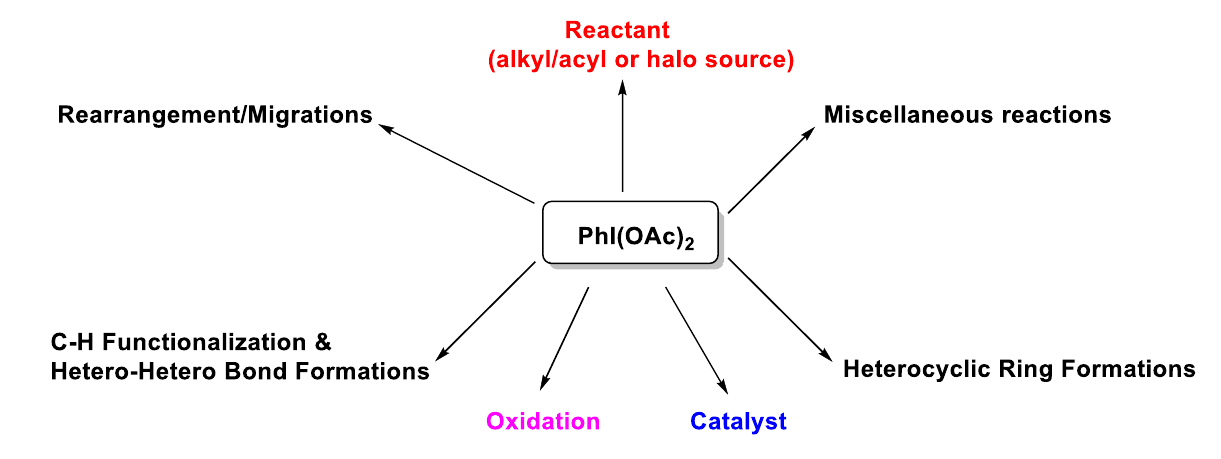
Figure 1. Structure of phenyliodine(III) diacetate (PIDA, 1 ).